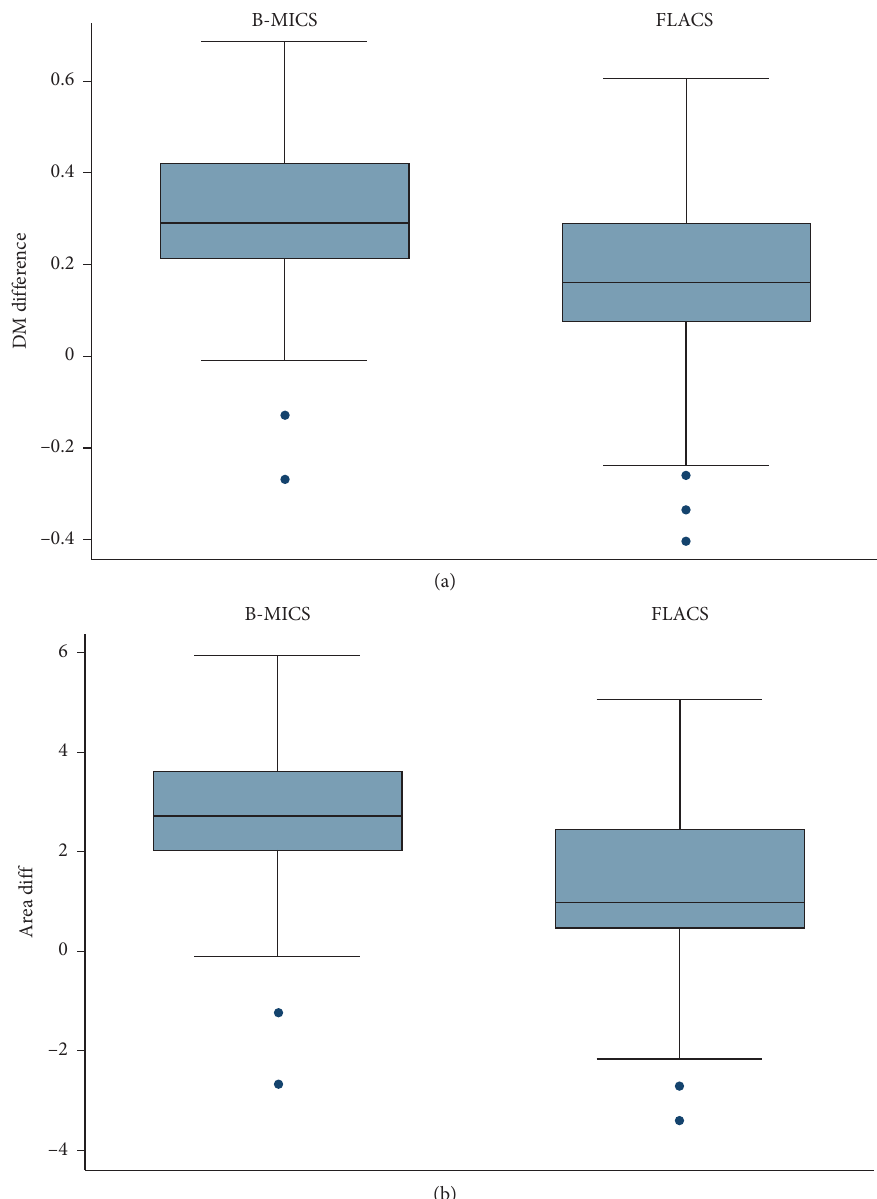
Figure 3: Box plot with whiskers indicating 95% confidence intervals for diameter (a) and area (b) variation in an 18-month follow-up period. DM �